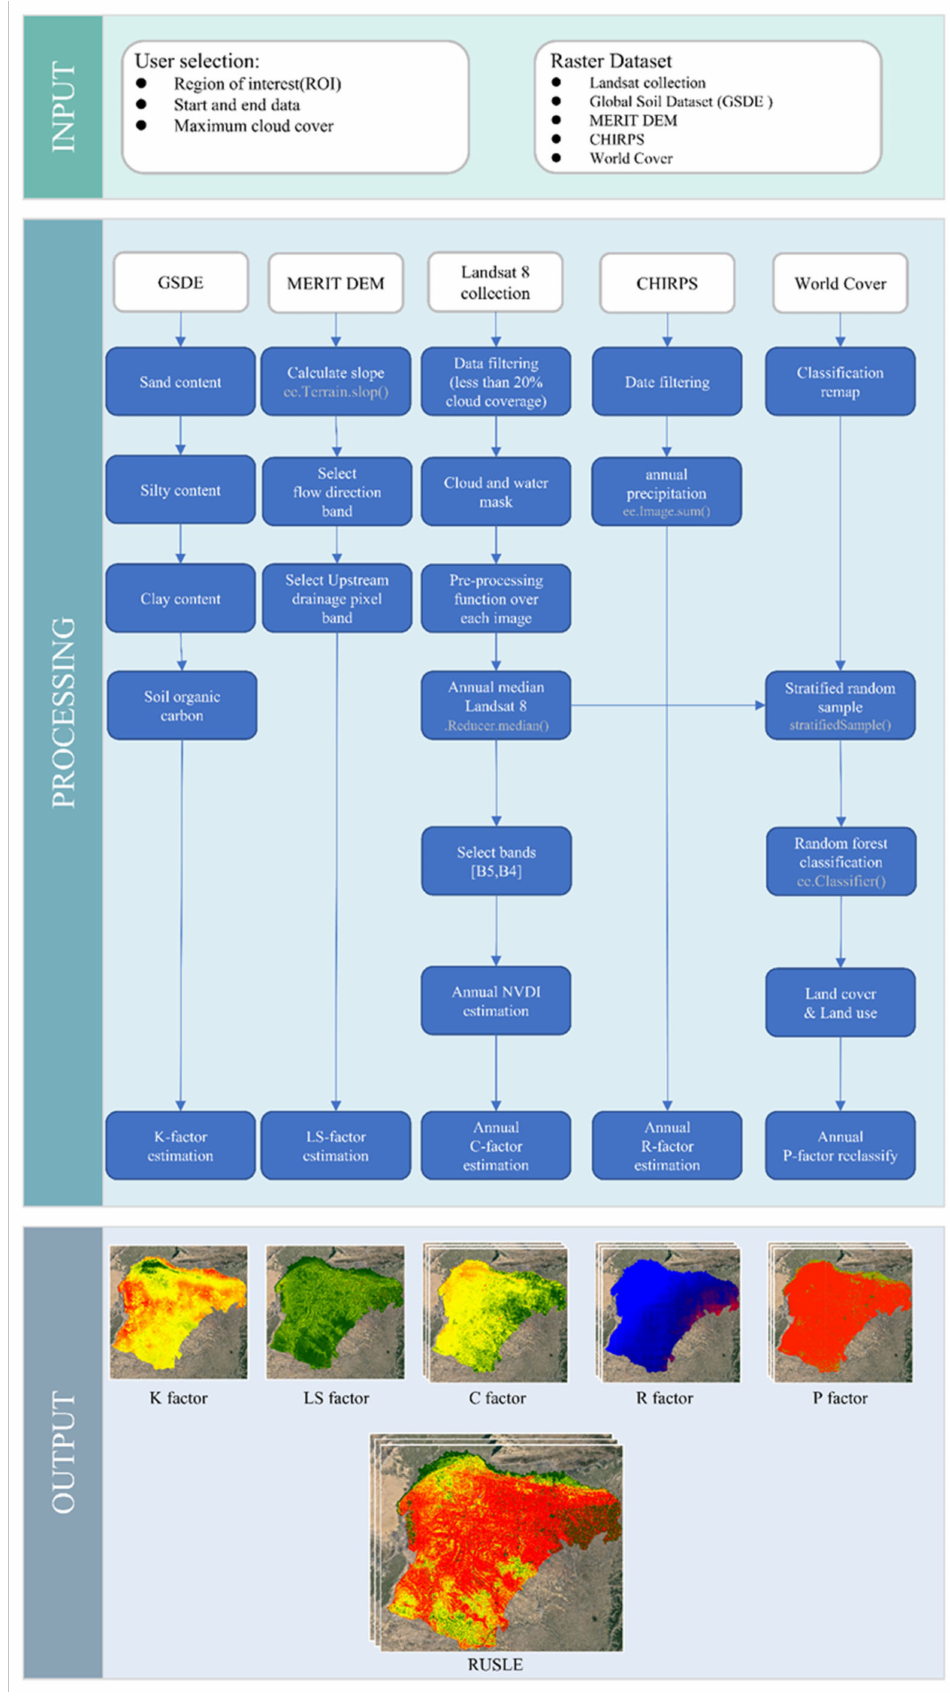
Figure 2. Methodological workflow of RUSLE calculation based on GEE